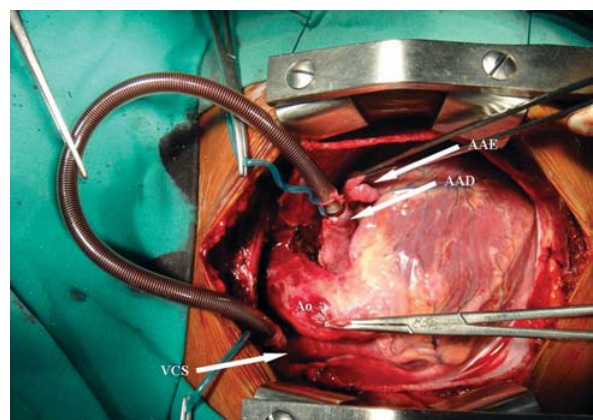
Fig. 2 – Aspecto intra-operatório com a cânula entre a VCS e o AAD. Nota-se a justaposição de apêndices atriais com o AAD e o AAE à esquerda. AAD: apêndice atrial direito, AAE: